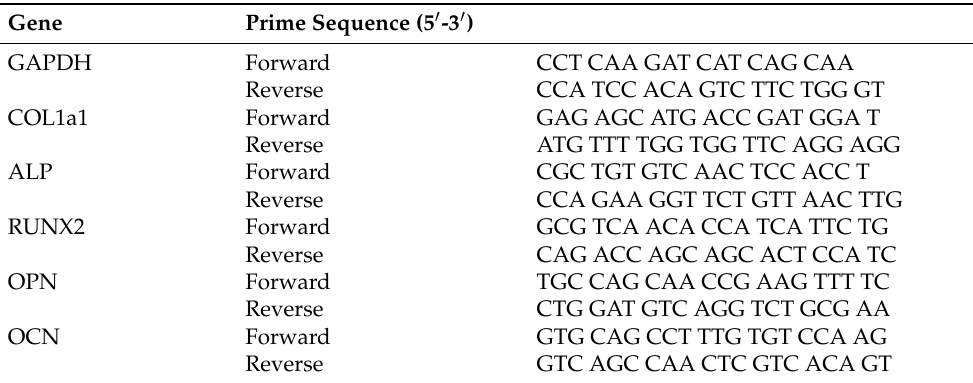
Table 1. Primers for real-time